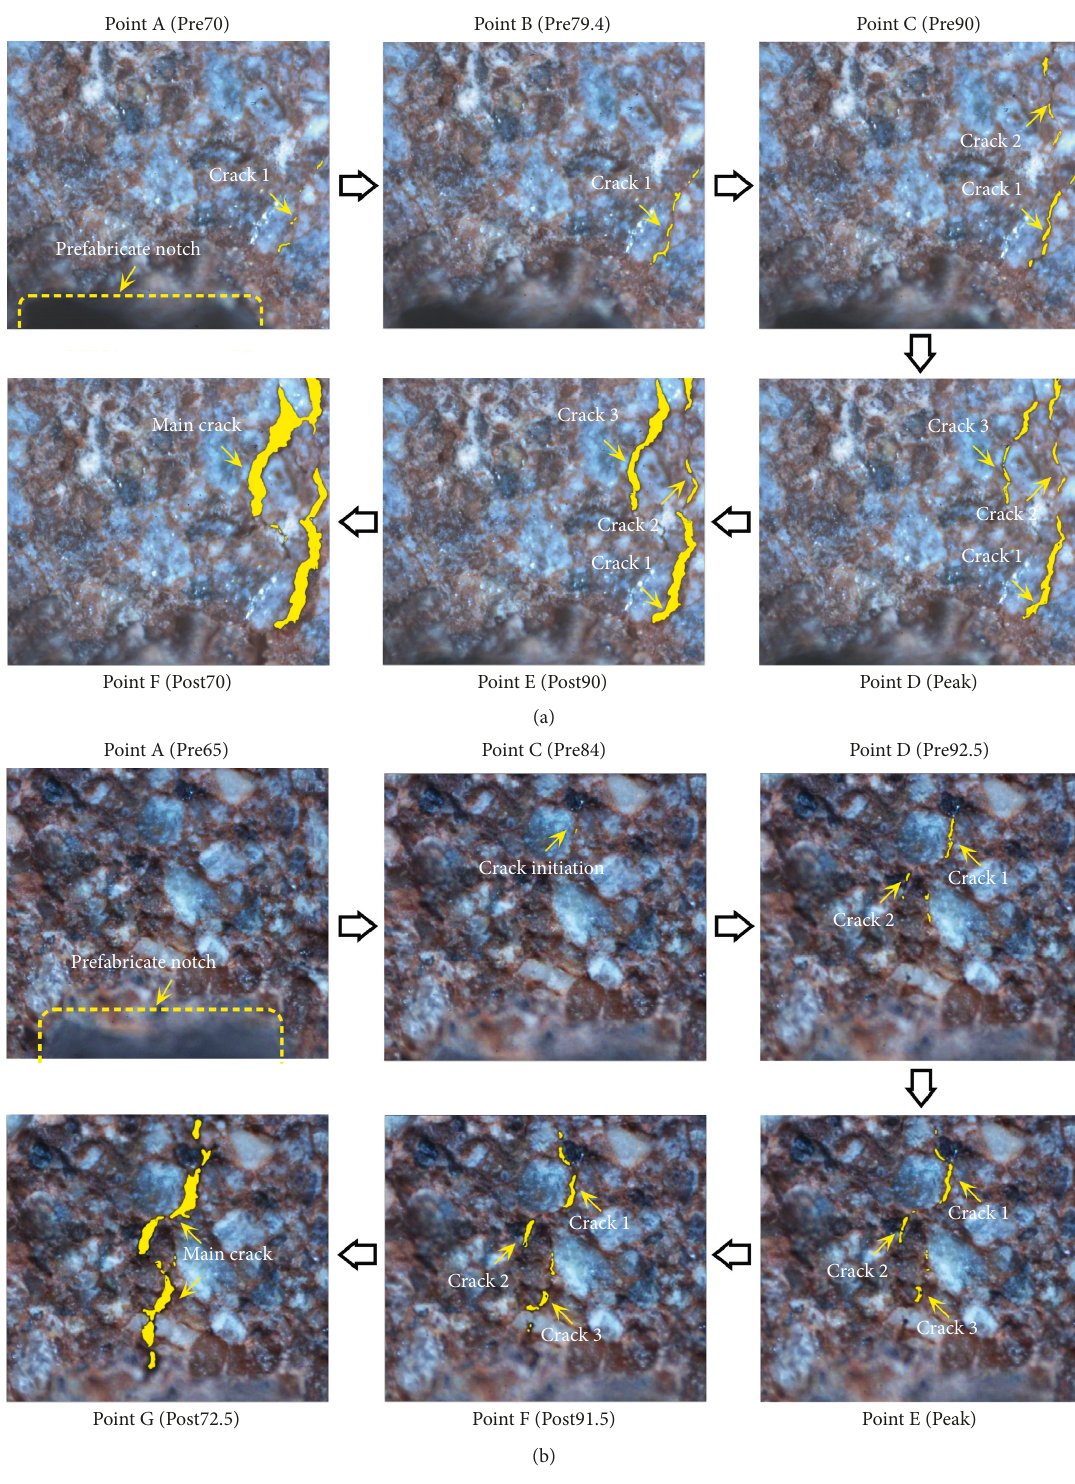
Figure 7: Microscopic cracking process with the field of view of 0.8mm × 1.0mm around notch tip under the typical loading rates of (a) 0.6mm/min (TPB-0.6-1) and (b) 3.0mm/min (TPB-3.0-1) observed using the microscopic visualization monitoring system. “Pre70” denotes the 70% of P peak prior to the peak, while “Post90” denotes the 90% of P peak after the